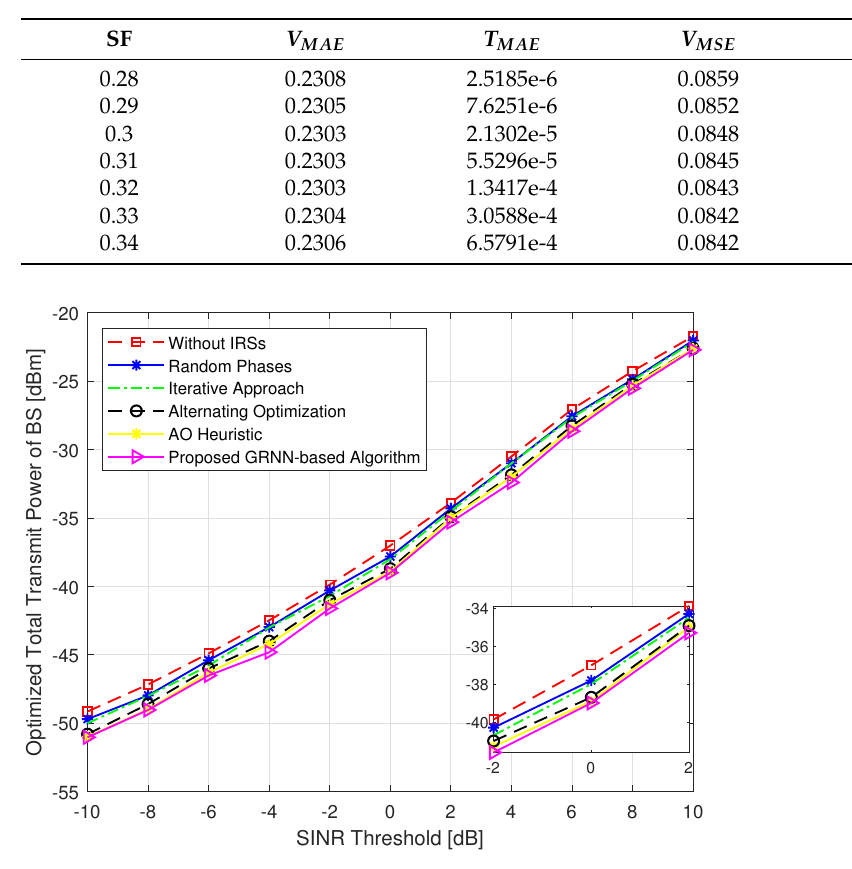
Figure 6. Optimized total transmit power of BS versus the SINR threshold under different